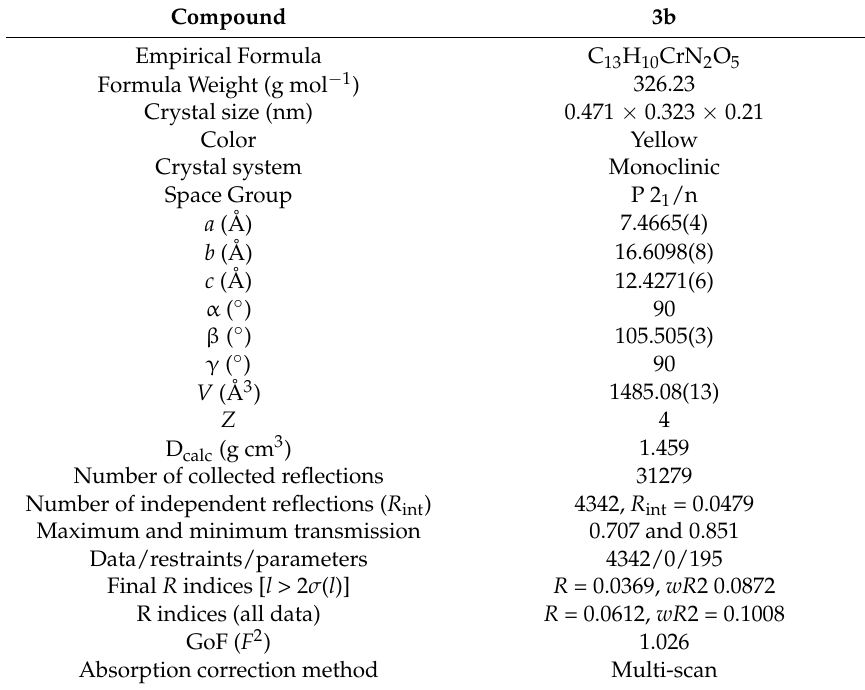
Figure 1. ORTEP view of complex 3b . Thermal ellipsoids at 30% probability level. Table 1. Crystal data and structure refinement for 3b